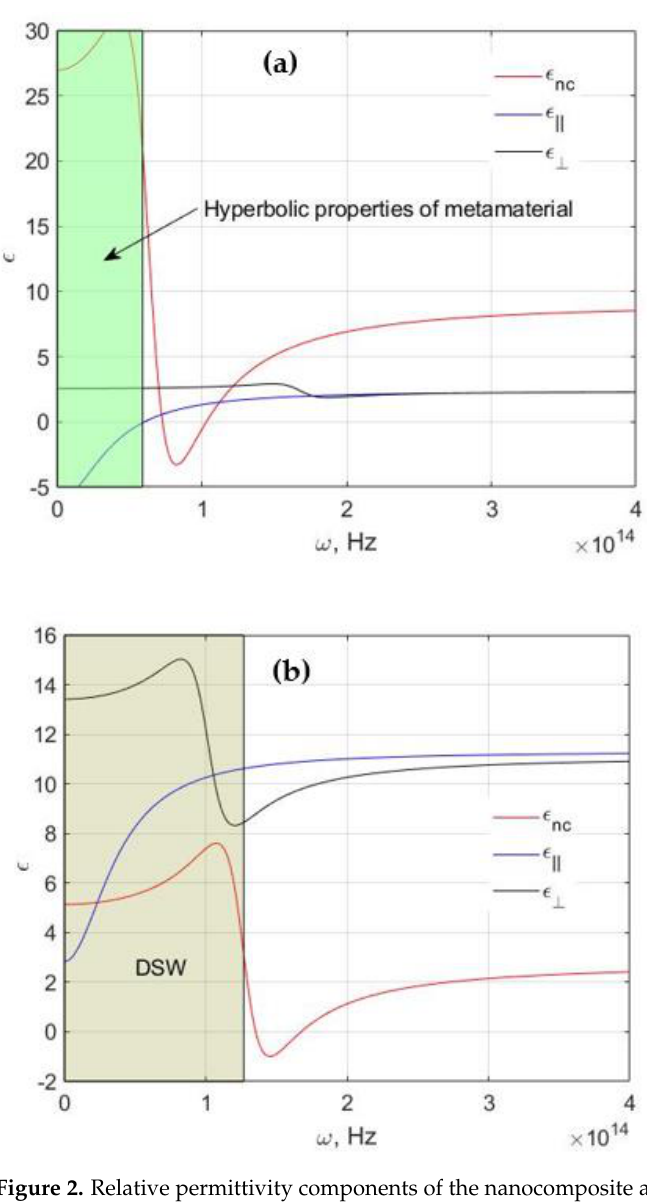
Figure 2. Relative permittivity components of the nanocomposite and hypercrystal versus frequency. Herein, f = 0.3. ( a ), ε n = 11.8, ε d = 2.25; ( b ) ε n = 2.25, ε d = 11.8. Herein ITO inclusions are employed in nanocomposite and hypercrystal.